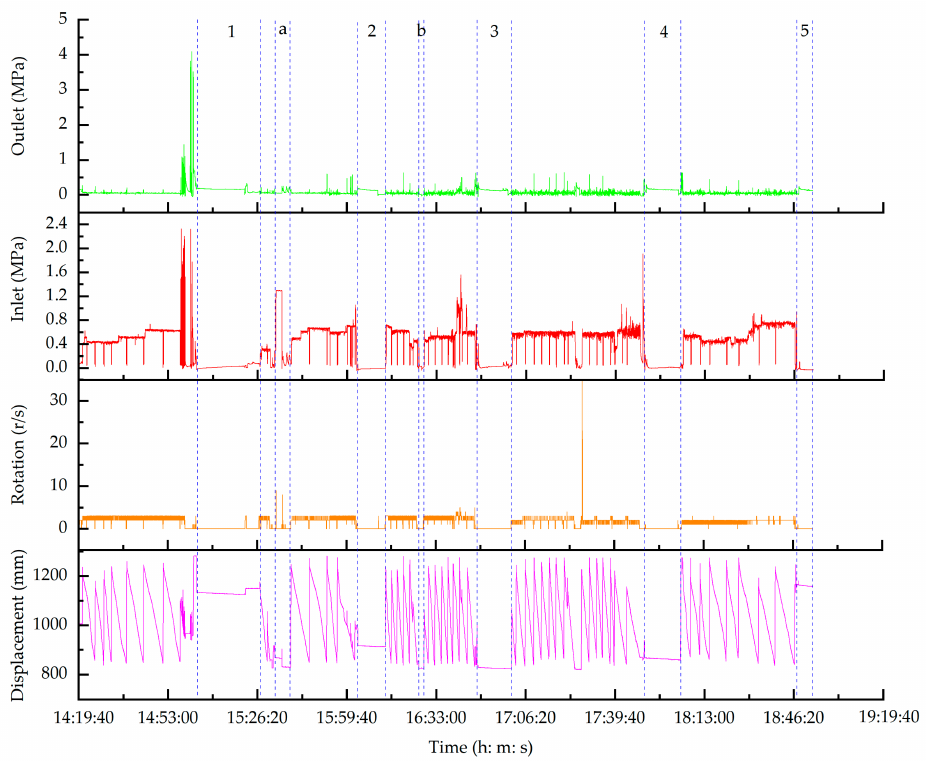
Figure 6. Rock-breaking response information–drilling time curves of a drilling rig drilling in Yan’an city on 9 September 2018 (drilling depth: 10.20–29.34 m).